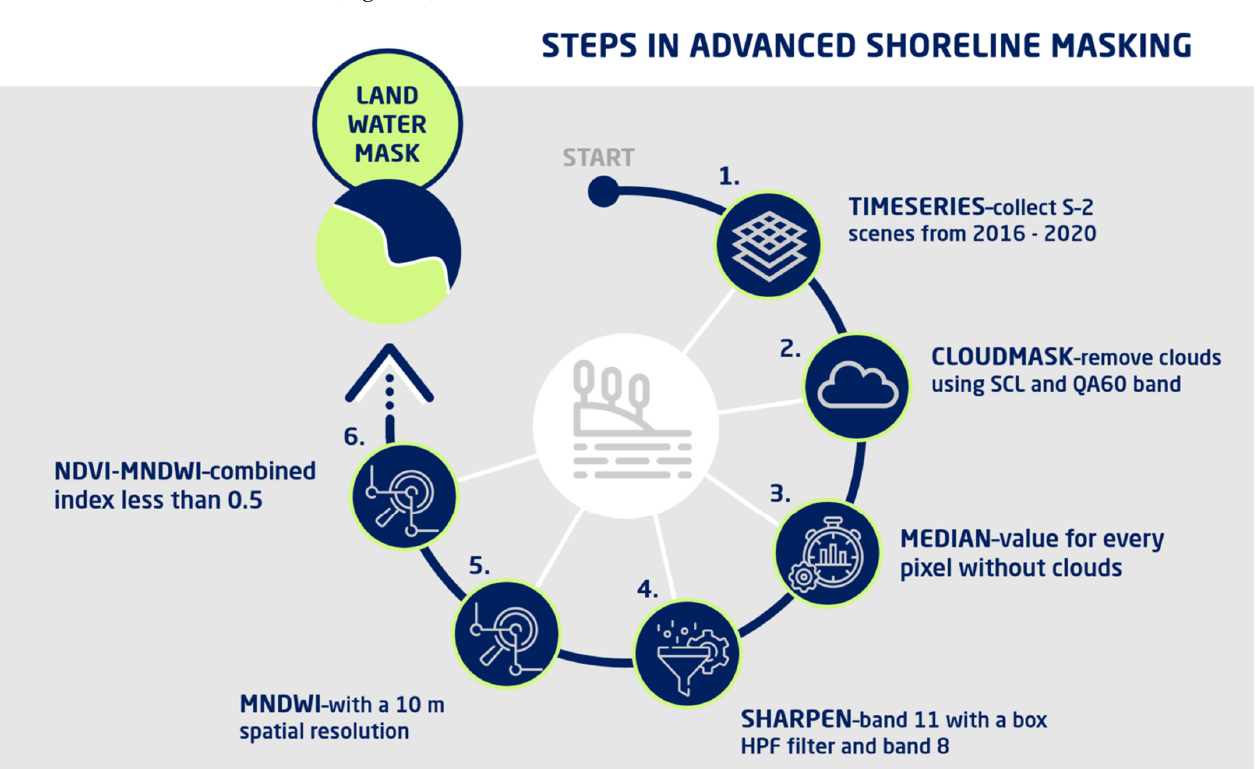
Figure 3. The six steps of the land-water mask creation with preservation of the sandy beach area.